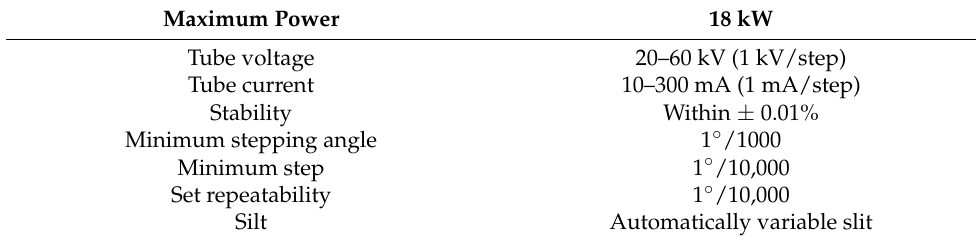
Table 4. Technical index, D/MAX X-ray